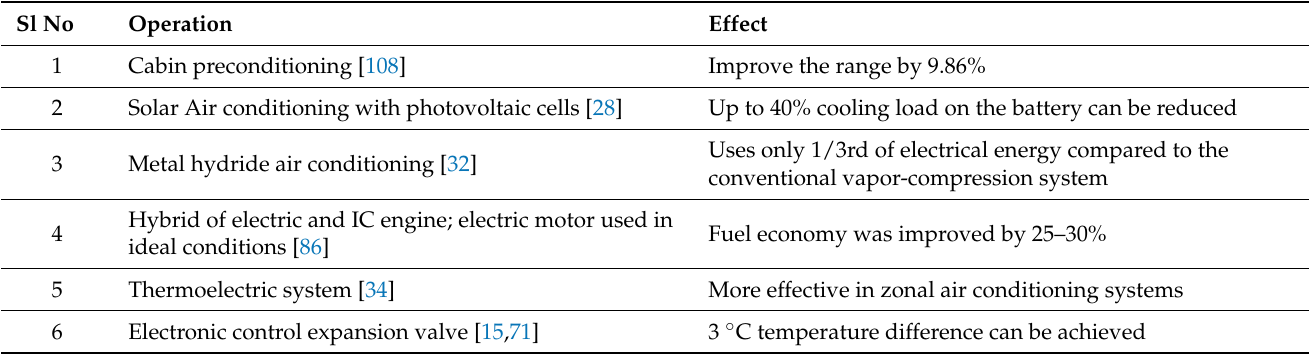
Table 8. Other factors and their effects on energy